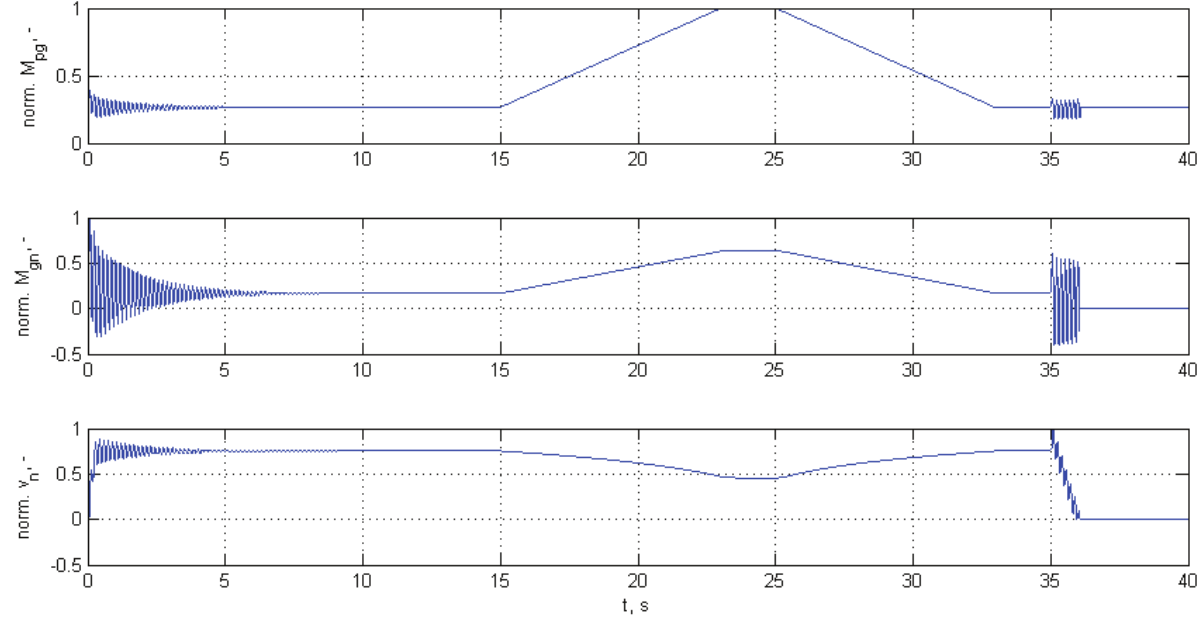
Fig. 6. Results of simulation following the scenario: idle run-up, loading, unloading, run-down